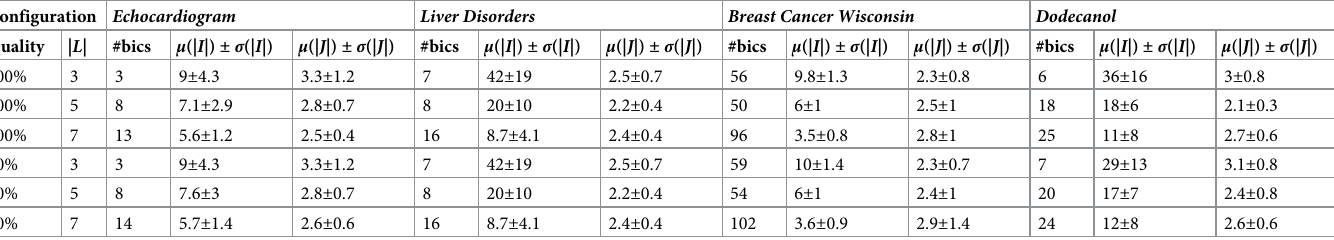
Table 3. Configurations used in BiCPAMS and best results from the four case studies. Each row from left to right indicates the percentage of noise allowed, the number of categories for the continuous variables (coherence strength), the number of extracted patterns, the average number of columns in each patterns (and standard deviation), and the average number of rows in each pattern (and standard